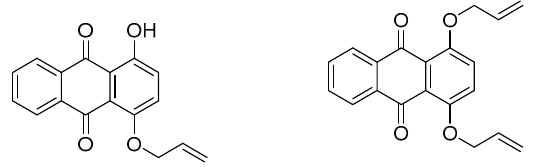
Figure 8. Anthraquinone monomers used in poly(vinyl chloride) (PVC) membranes for lead waste water purification